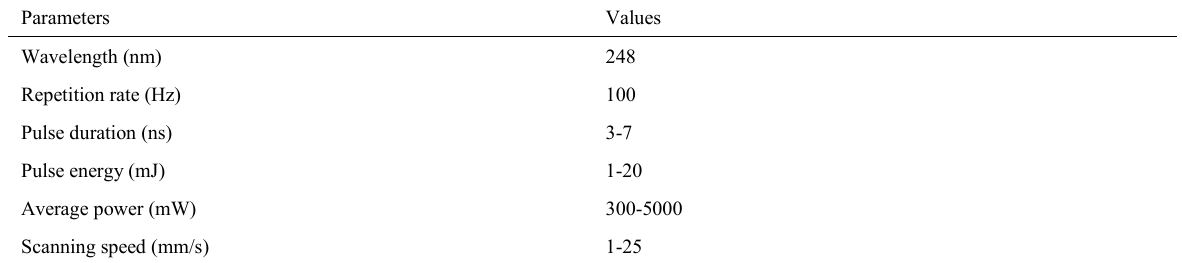
Table 1: KrF excimer laser and beam specifications.